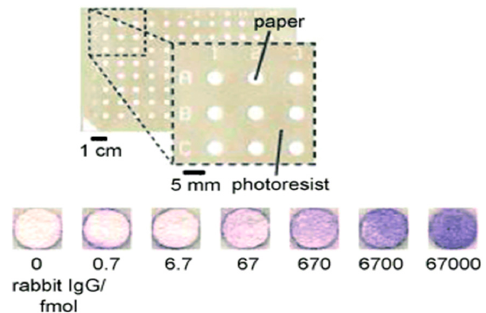
Figure 4. A 96-microzone paper-based ELISA [92]. Reproduction of the figures is made with permission of Wiley.